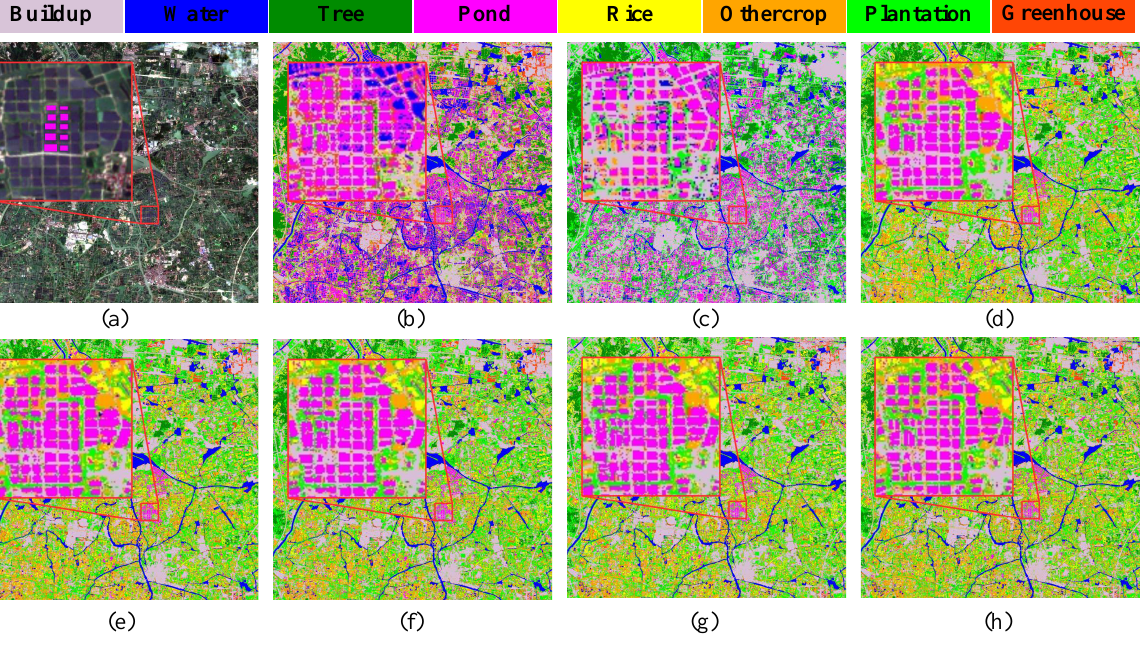
Figure 10. Classification results obtained by different models applied on Nanxun district dataset: ( a ) Image; ( b ) SVM; ( c ) 1D CNN; ( d ) RNN; ( e ) Transformer (ViT); ( f ) SpectralFormer; ( g ) FC + 2D CNN; and ( h )